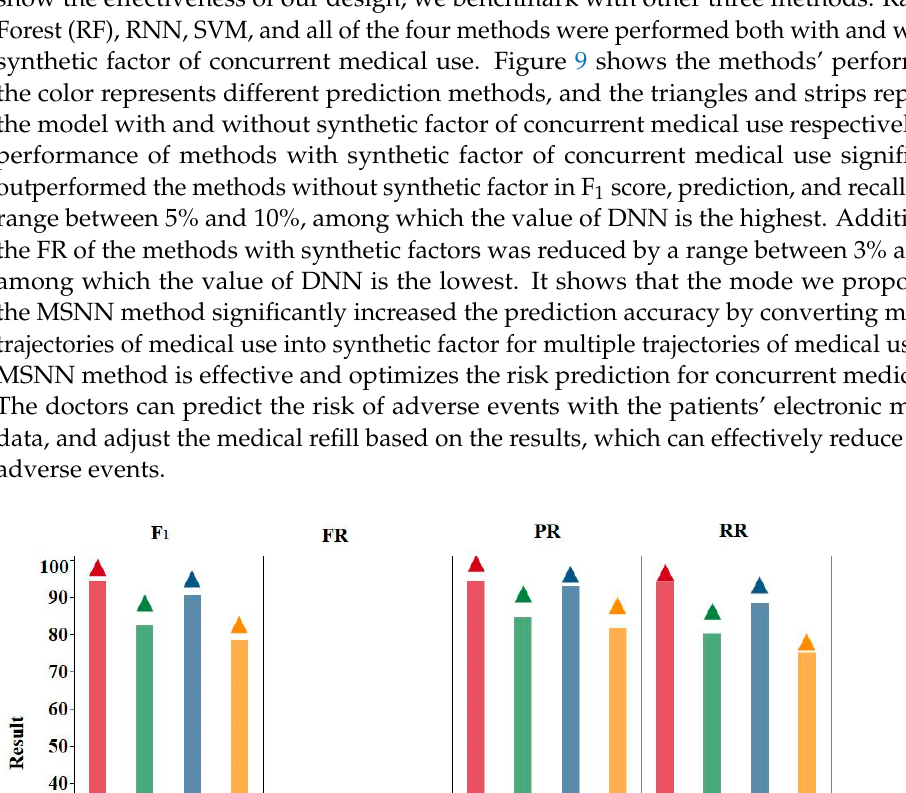
Figure 8. Comparison of va ttriables that contribute to trajectories.